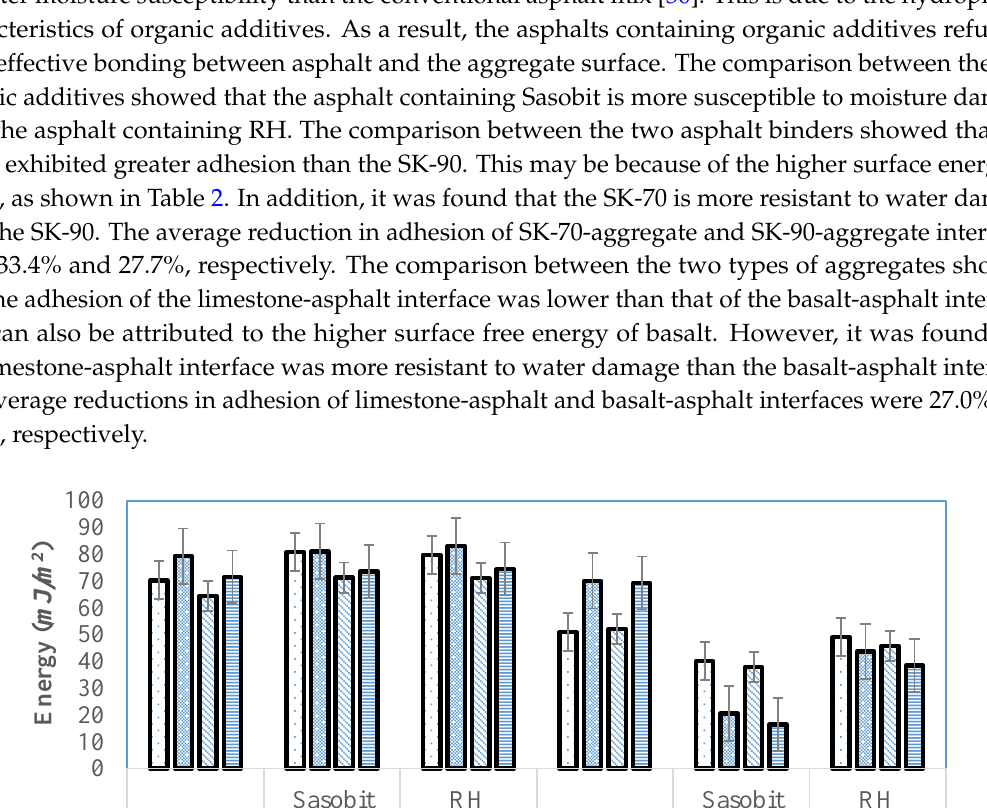
Figure 5. Adhesion of the Asphalt-Aggregate Interface in Different Conditions (mJ/m 2 ).